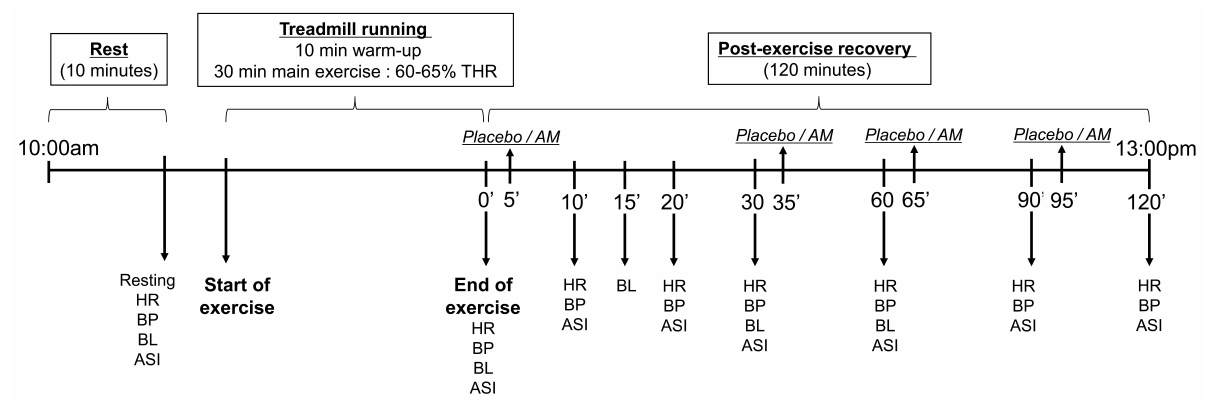
Fig. 1. Representative experimental procedure. HR, heart rate; BP, blood pressure; BL, blood lactate; ASI, arterial stiffness index; THR, target HR; AM, antibacterial mouthwash.